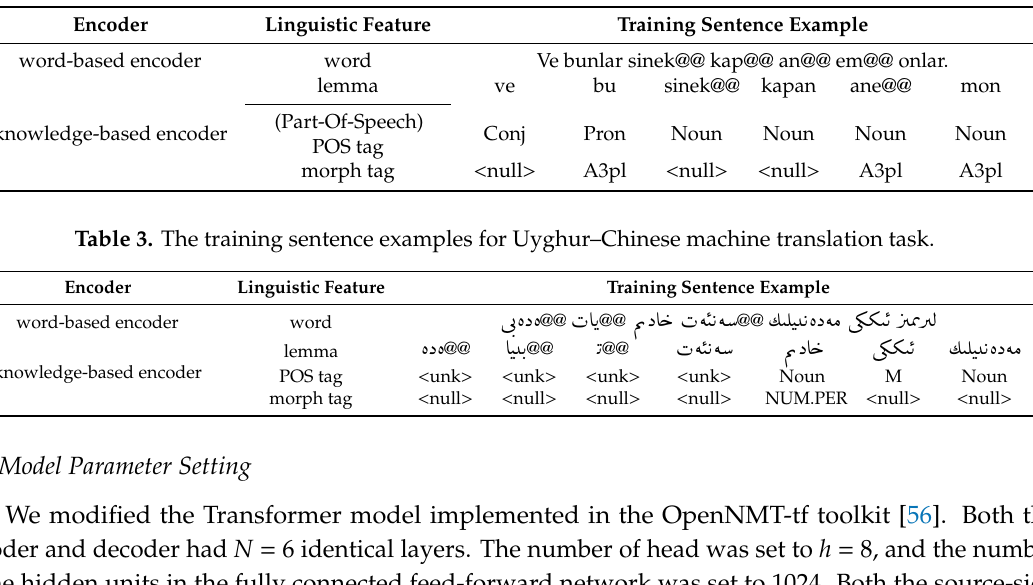
Table 2. The training sentence examples for Turkish–English machine translation task.